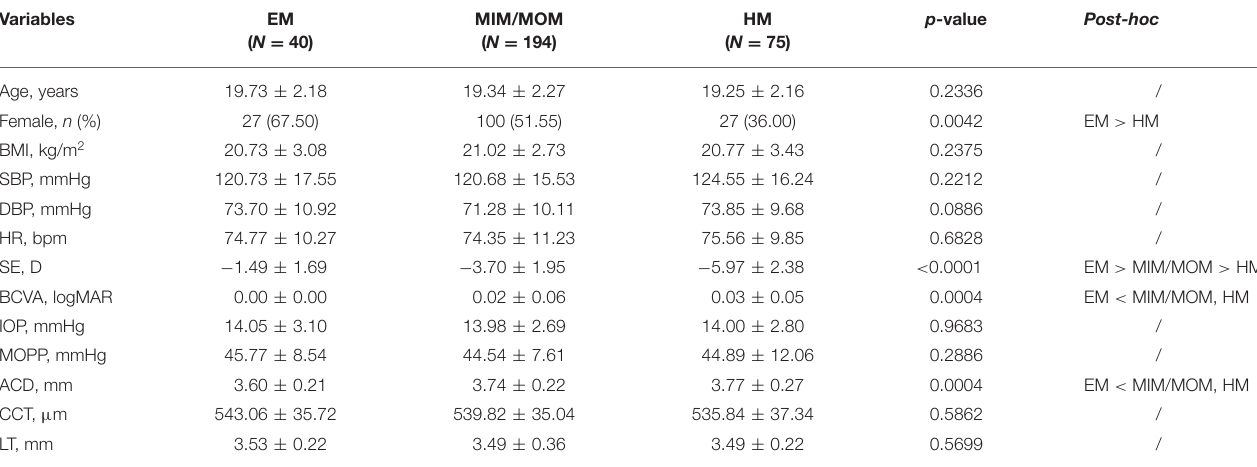
TABLE 1 | Demographic and ocular characteristics of study participants.